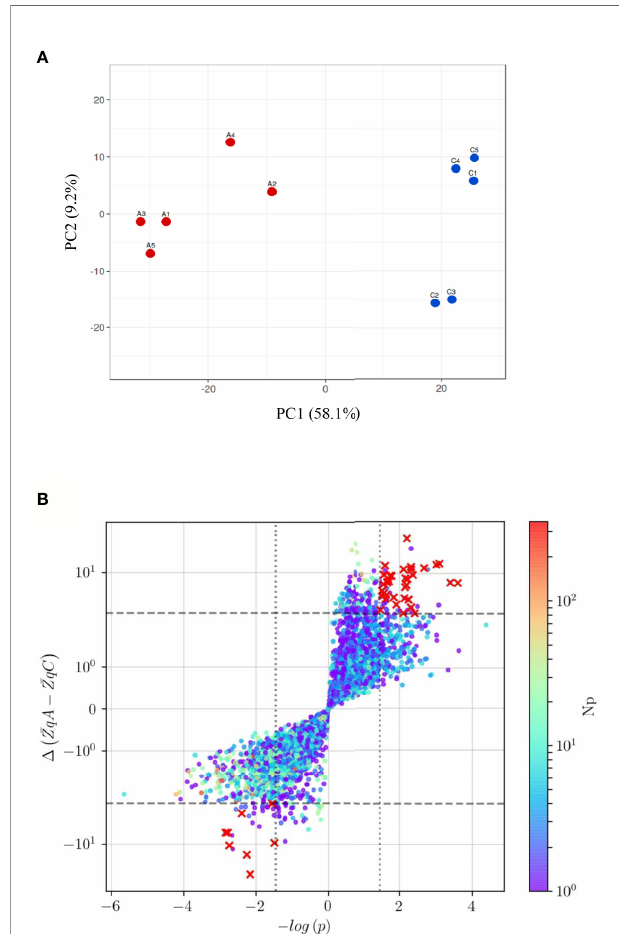
FIGURE 3 | Principal Component analysis (PCA) and protein distribution of the EC-anaphylaxis- and control- sera/EC systems (A) PCA of the TMT10plex ™ from the EC-anaphylaxis and EC-control set of proteins. Color coding: in red, the EC-anaphylaxis group (A1, A2, A3, A4, and A5) and in blue, the EC-control (C1, C2, C3, C4, C5). PC1, principal component 1; PC2, principal component 2. (B) The red crosses in the upper-right and lower-left quadrants indicate proteins presenting altered levels between EC-anaphylaxis and EC-control. The criteria applied were as follow: Np ≥ 3, color scale; | D Zq| > 3, marked by the horizontal dashed line and Student ’ s t test with logarithmic transformation (|-log (p)> 1.5), delimited by the vertical dotted line. Y-axis and color scale are presented in logarithmic scale. Np, number of peptides; D Zq, mean difference of